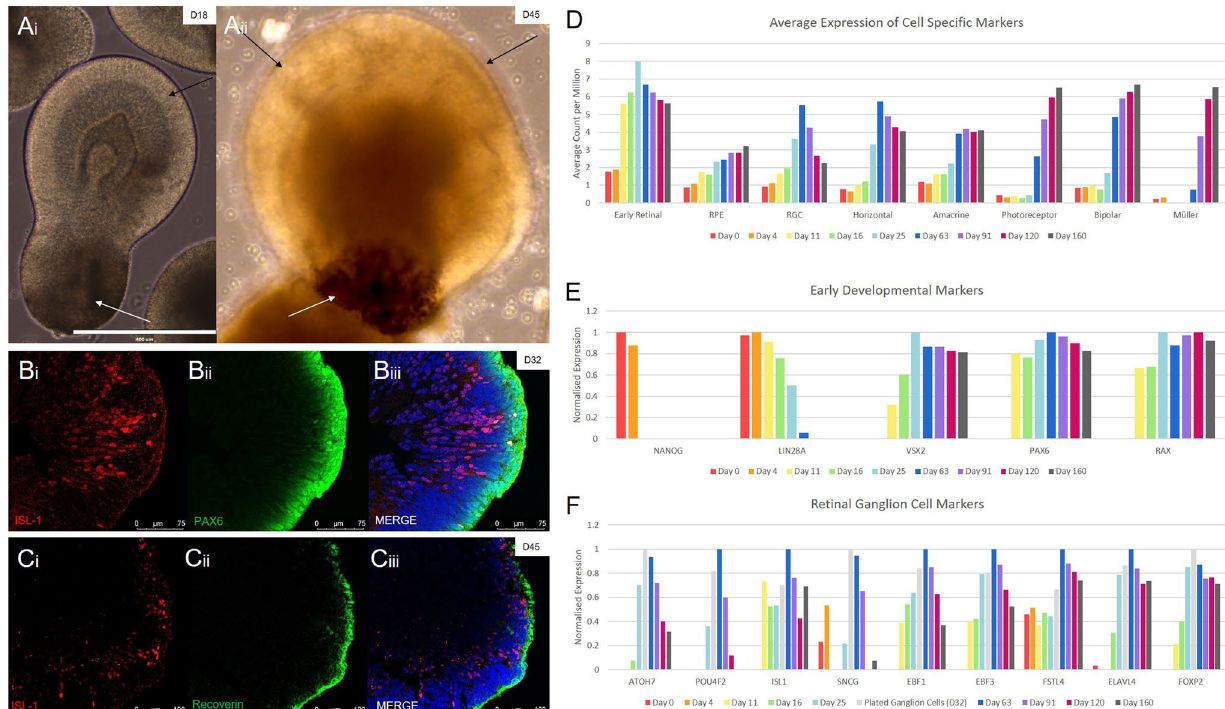
Figure 3. Confirmation of retinal organoid development. ( Ai-ii ) Whole organoids were observed to have clear portions of neural retina (black arrows) and pigmented cells (white arrows) as early as day 18 (Scale Bar = 400 µm). ( Bi-iii ) Cross sectioned IHC analysis showed the formation of a distinct ganglion cell layer, shown here using the ganglion marker ISL1 (in red). ( Ci-iii ) A separation of the inner ganglion layer (shown by ISL-1 in red), and the outer photoreceptor layer (shown by the common photoreceptor progenitor marker RCVRN, in green), was seen by day 45. ( D – F ) Quantitative RNA sequencing data of cell specific markers showed sequential development of retinal cell types in our organoids in line with other published protocols. ( D ) An average of multiple markers for each cell type show cell development over time. ( E ) Common